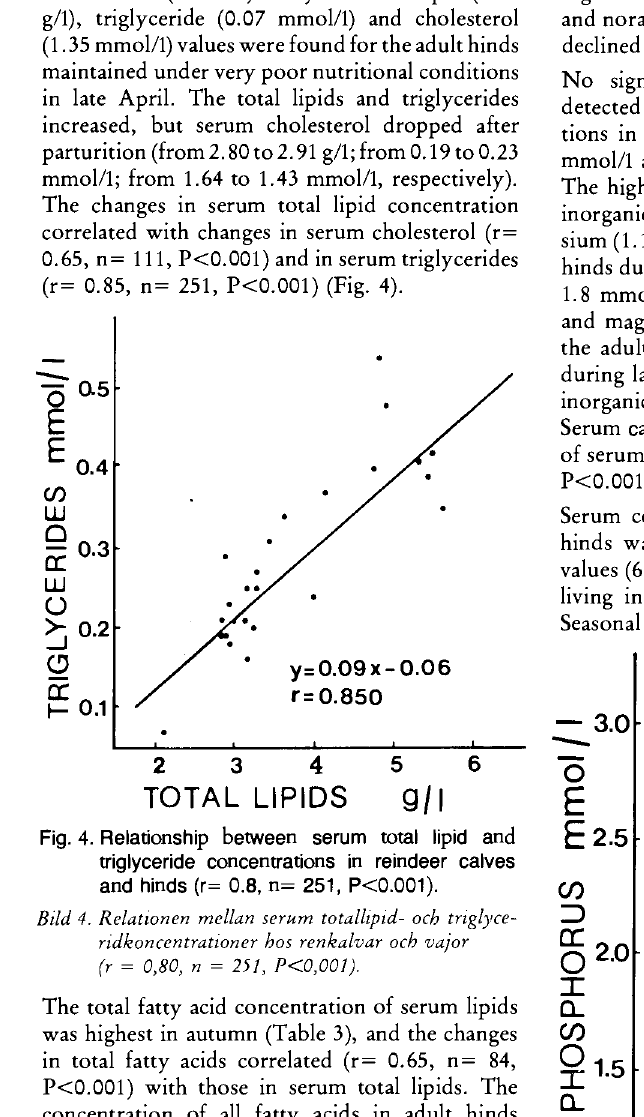
Fig. 4. Relationship between serum total lipid and triglyceride concentrations in reindeer calves and hinds (r= 0.8, n= 251, P<0.001).